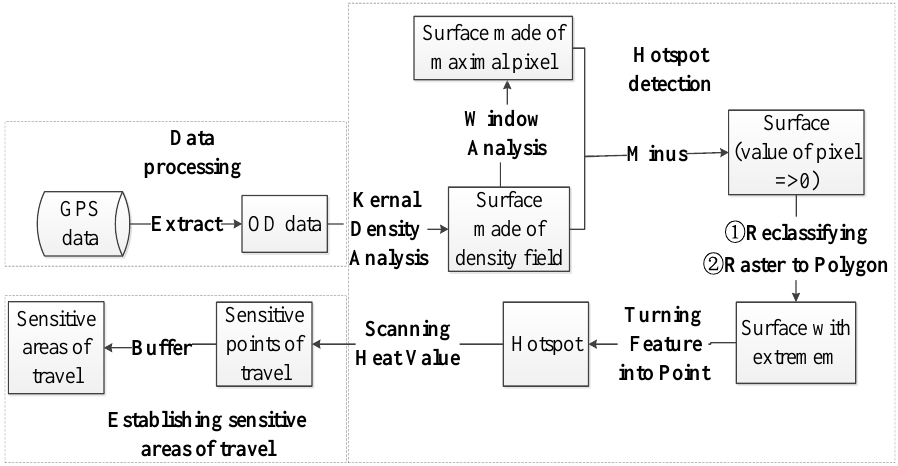
Figure 2. The flowchart of hotspot detection.